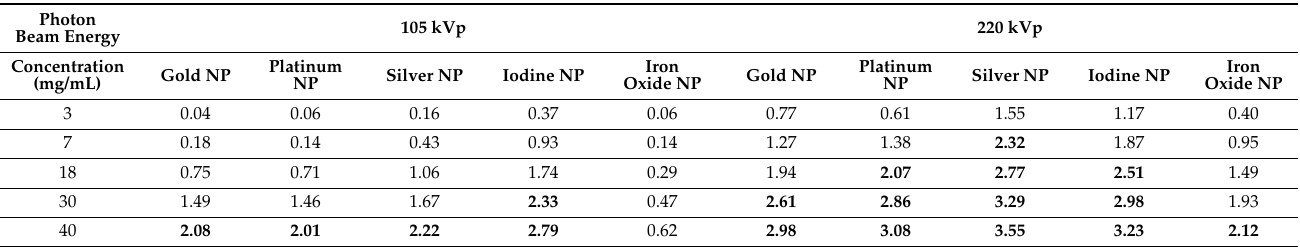
Figure 2. Relationships of dose enhancement ratio and NP concentration (mg/mL) with variations of photon beam energies (105 and 220 kVp) and presence of bone for ( a ) gold, ( b ) platinum, ( c ) silver, ( d ) iodine, and ( e ) iron oxide NPs in Monte Carlo simulations. Table 1. Difference of DER (%) between bone under the skin and no bone under the skin in the Monte Carlo simulation, using various NPs, NP concentrations, and photon beam energies. Differences of DER values are marked in bold where statistically significant ( p < 0.05).